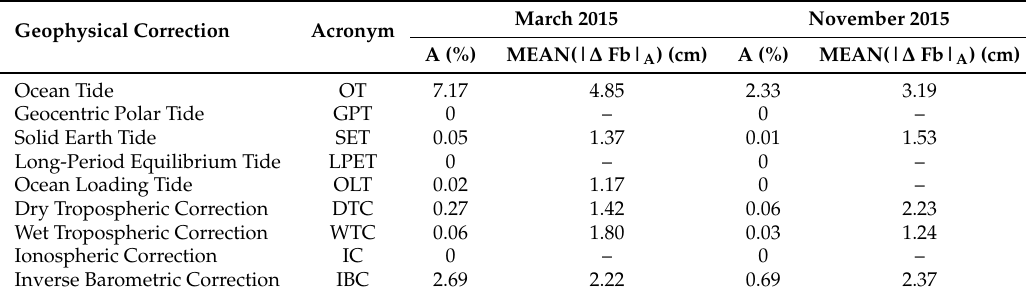
Table 1. List of applied geophysical corrections. For the different runs they are switched on individually. The area fraction A is calculated as the percentage of all valid CS2 freeboard grid cells of a month that are affected by the specific geophysical correction greater than 1 cm. MEAN(| ∆ Fb| A ) is the mean of the impact on the freeboard for the grid cells contained in